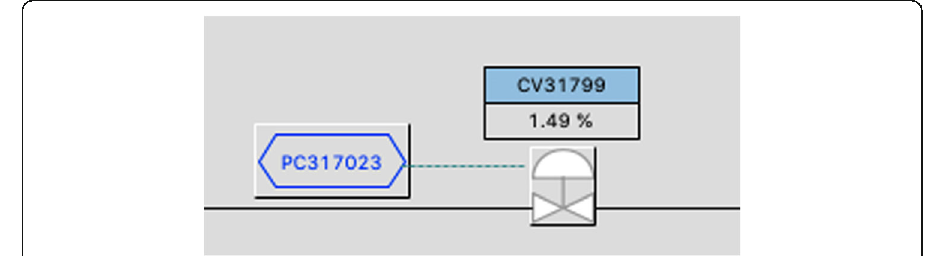
Fig. 8 Controller symbol